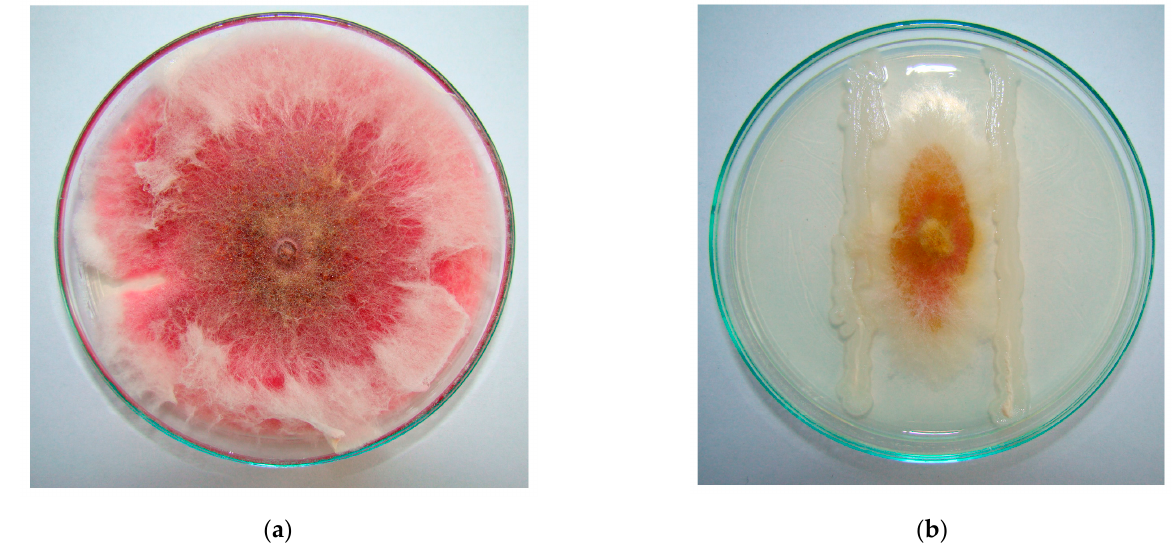
Figure 7. 10-day-old colonies of microorganisms on the potato dextrose agar (PDA) medium: ( a ) Fusarium culmorum ; ( b ) Fusarium culmorum with Bacillus sp.; (photo by E. Patkowska).